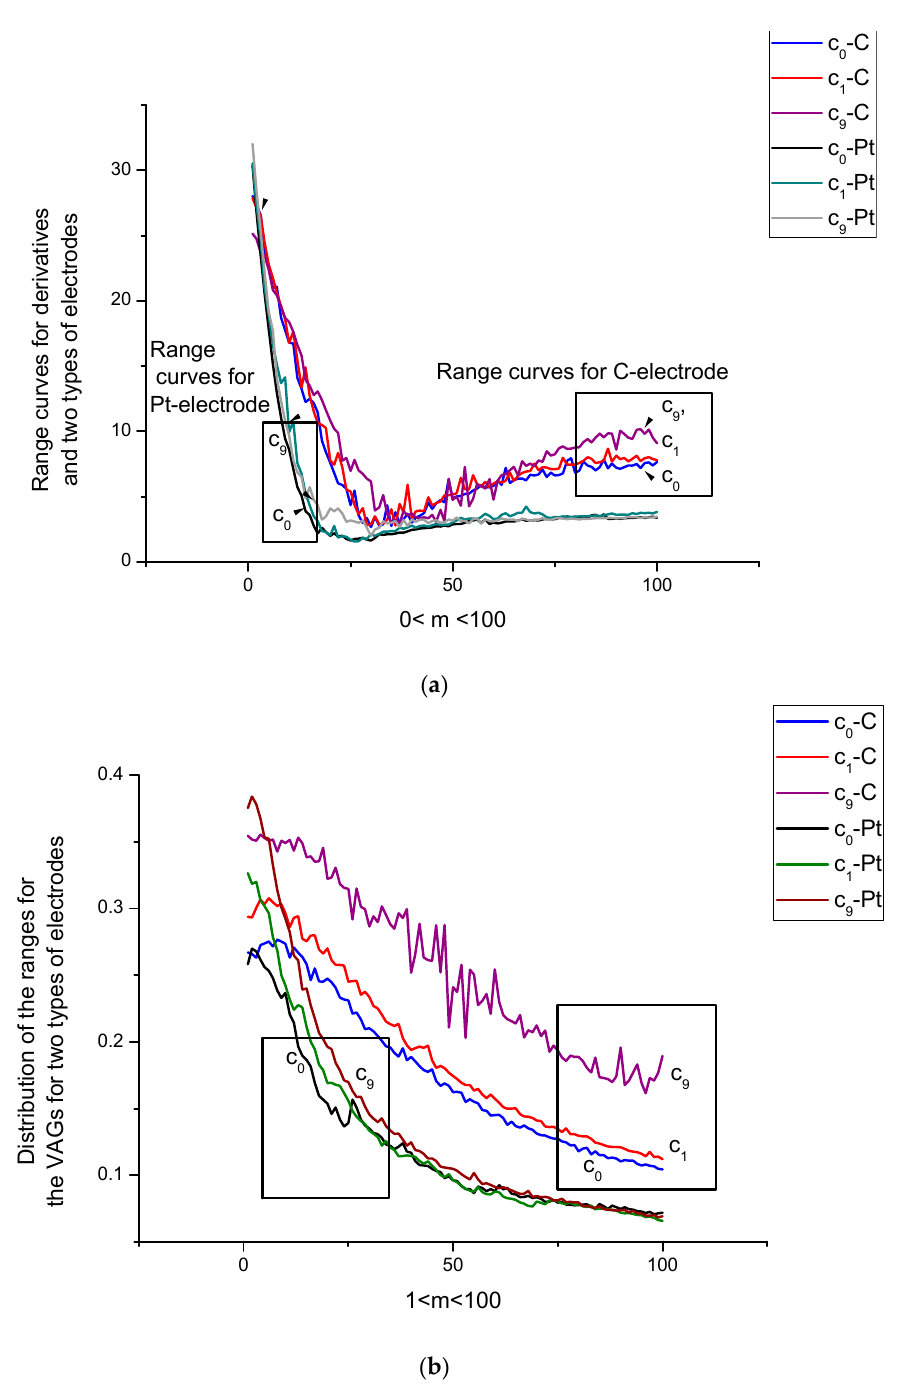
Figure 3. ( a ) Distribution of the ranges for differential (d J /d U ) VAGs in the measurement space. One hundred measurements for c 0,1,9 were repeated in the same experimental (temperature, pressure, humidity, pH) conditions. The period of one VAG registration was 3 s. The duration between measurements was 10 s. One can notice that the chosen minimal concentration c 1 was very close to the curve, corresponding to the c 0 concentration for both types of electrodes. All measurements were reduced to the same interval [1,100]. ( b ) Distribution of the ranges for the usual VAGs for the same values of concentrations c 0,1,9 . In comparison with the previous figure, these curves become more sensitive to the presence of D -tryptophan in the buffer solute and, hence, more preferable for further analysis.